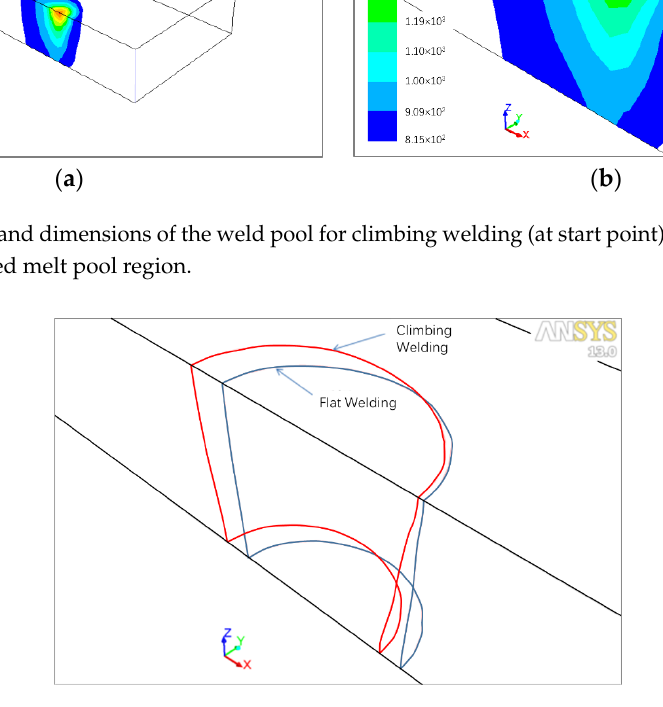
Figure 7. Comparison of the weld pools for flat and climbing welding positions.